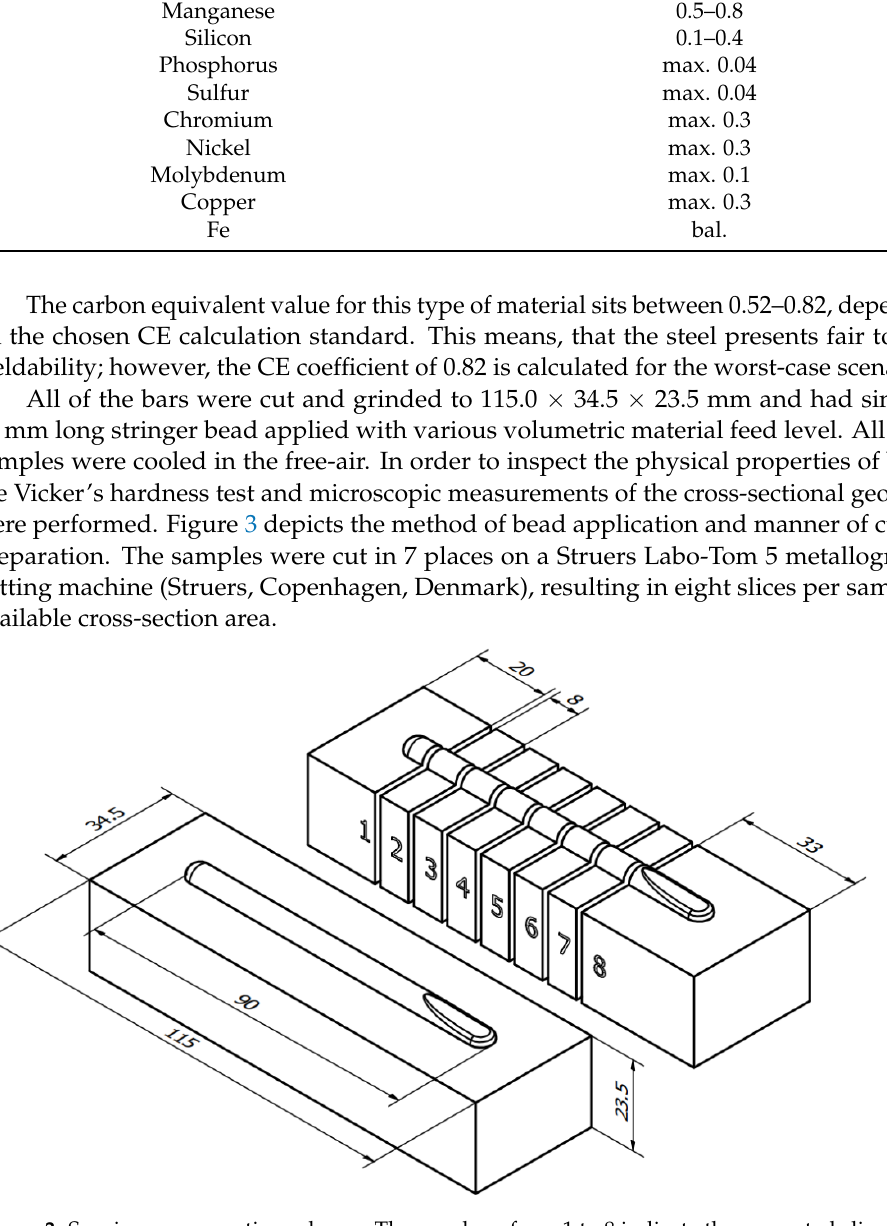
( b ) Figure 4. View of the CNC Hardfacing Machine, codenamed NaPawlik v2.0. ( a ) depicts the CAD model, ( b ) shows the device in action. The CNC Hardfacing Machine is a cartesian robot with a GMAW welding gun, at- tached to the Kemppi X8 MIG welding machine (Kemppi, Lahti, Finland). The process relies on Duet2Wifi control (Duet3D, Peterborough, UK) board with modified software. The modifications of the software are minor, and they are limited to adding a special G- code command to ignite and supress the electric arc. Yet, this experiment can be re-run using any linear actuator with speed control.